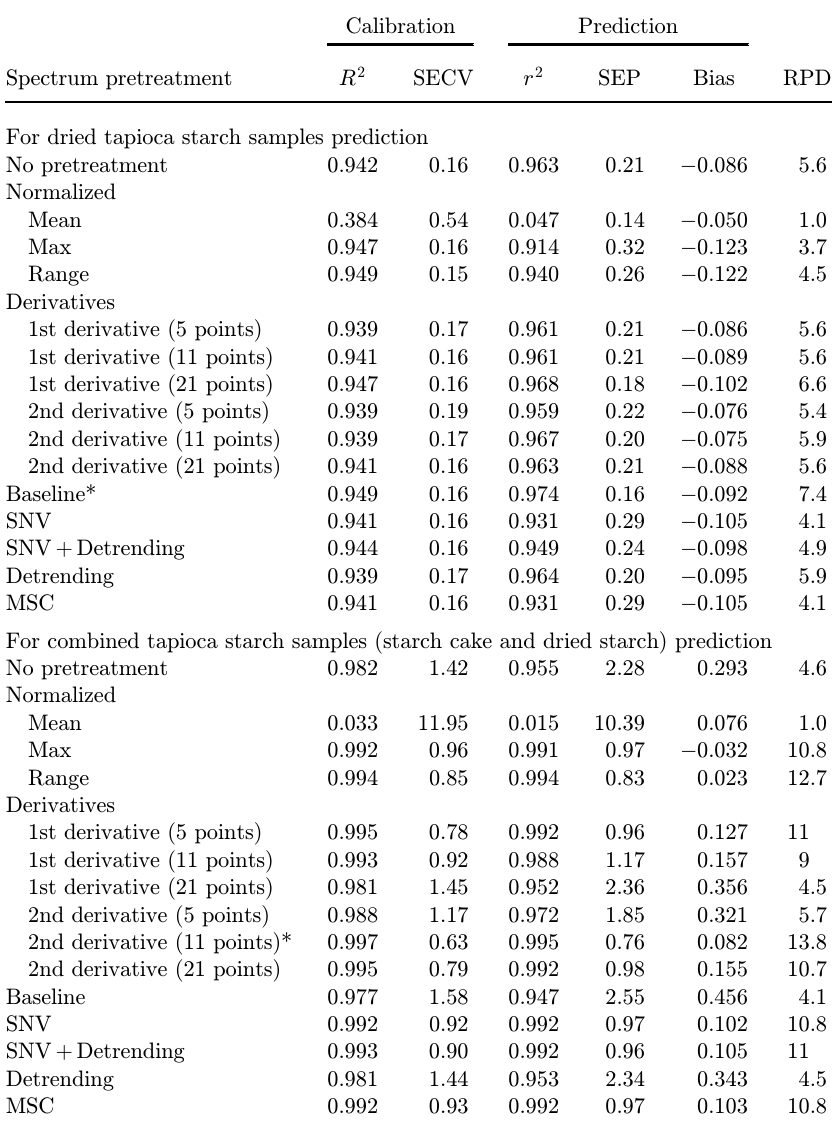
*Selected optimum model, coe±cient of determination for calibration model ( R 2 ), coe±cient of determination for prediction ( r 2 ), SECV, SEP, SNV, MSC and